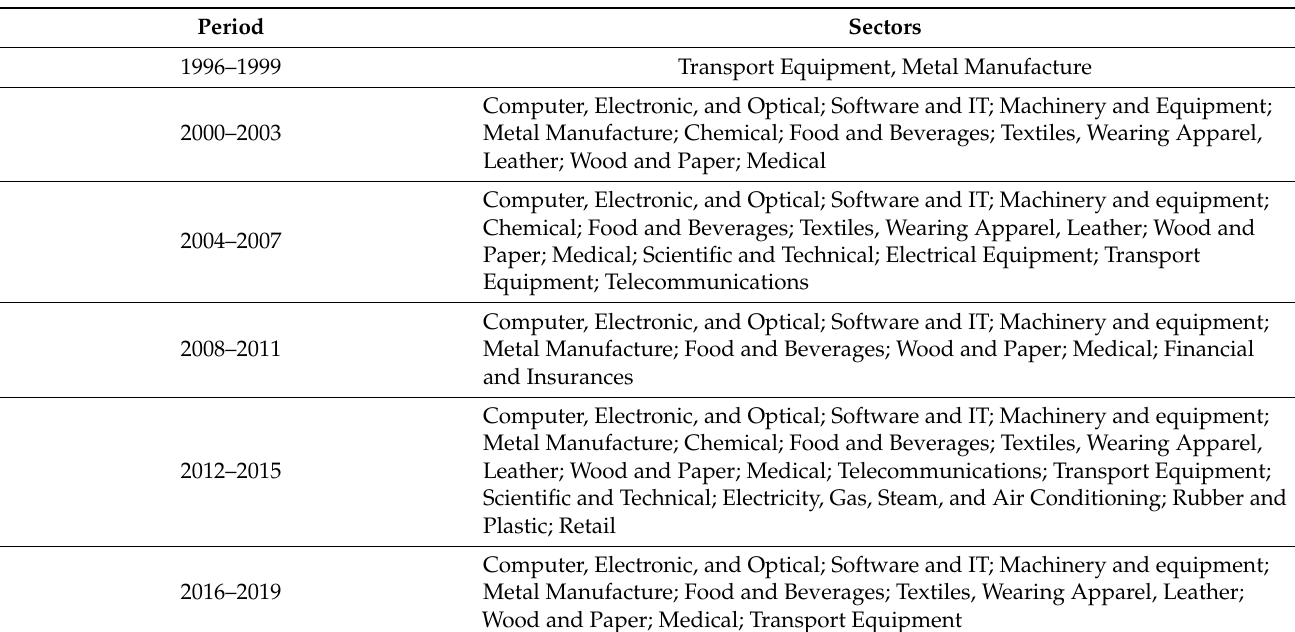
Table 4. Industry Table 4. Industry Sectors.